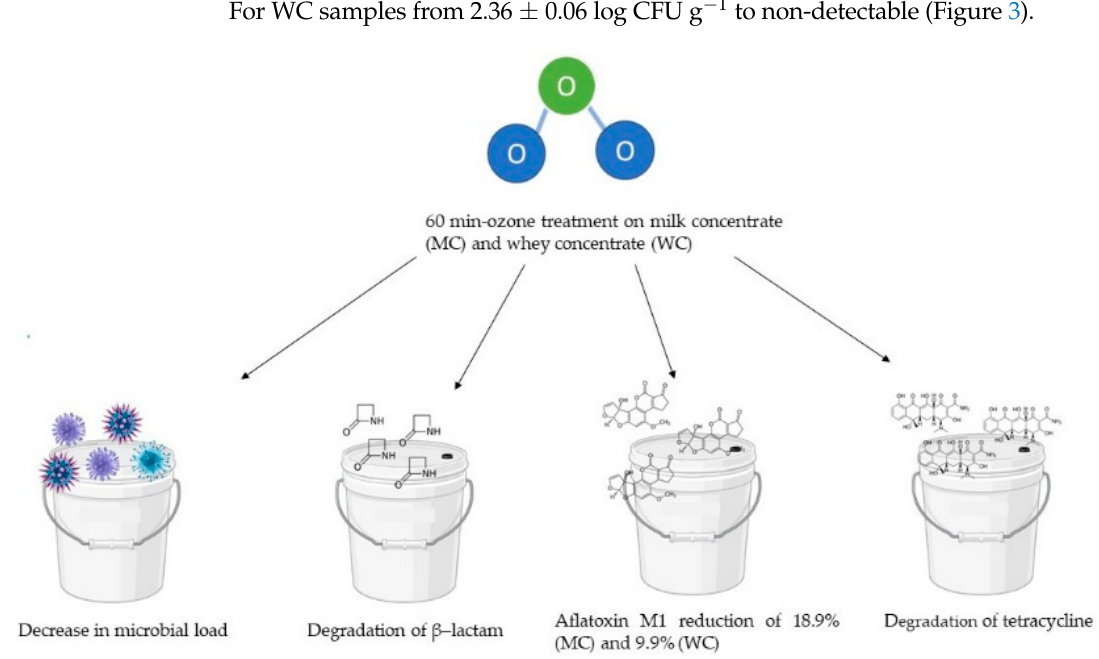
Figure 3. Main results after 60 min. of ozone treatment on milk and whey concentrate.